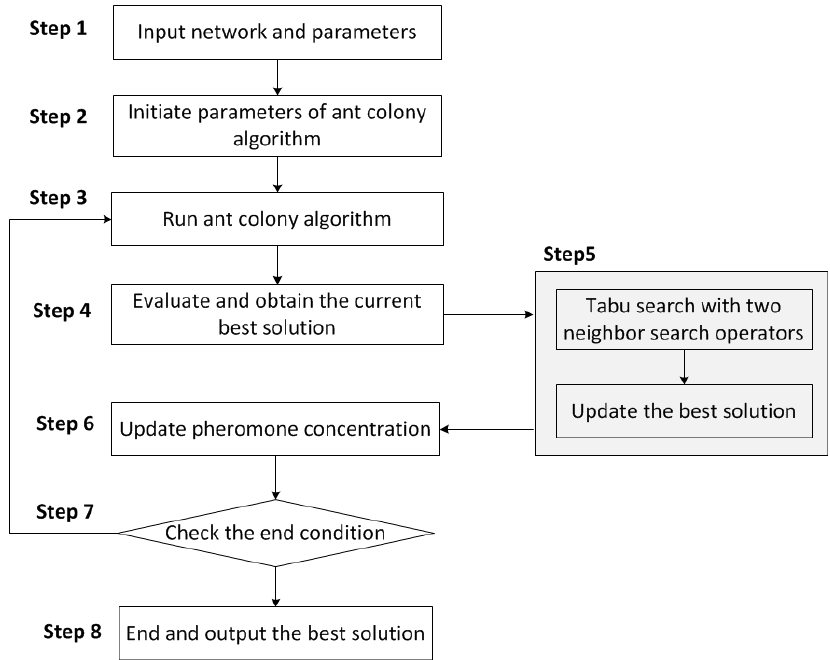
Figure 3. Overview of the hybrid optimization algorithm.